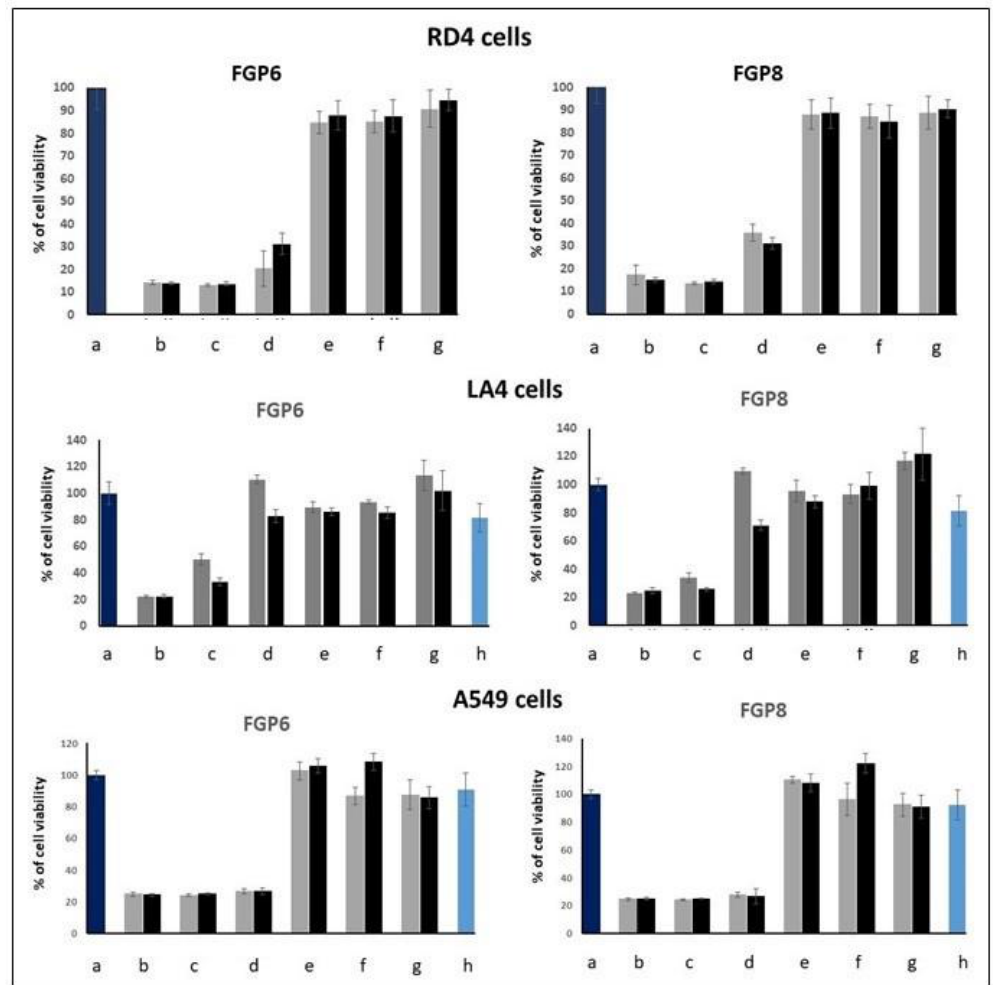
Figure 3. Effects of FGP6 ( left ) and FGP8 ( right ) on RD4 ( top ), LA4 ( middle ) and A549 ( bottom ) cell lines proliferation measured by MTT test after 48 h of incubation: ( a ) untreated cells; ( b ) 40 µM; ( c ) 20 µM; ( d ) 10 µM; ( e ) 5 µM; ( f ) 2.5 µM; ( g ) 1.25 µM; ( h ) only DOPE. In gray, FGP n alone; in black, FGP n : DOPE = 1:2. Values are the mean ±S.D. of three independent experiments ( n = 8 per treatment, p < 0.05). For GP16_6, the cytotoxicity is a little greater on RD4 cells than on A549 cells. Above